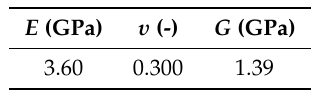
Table 1. Elastic properties of epoxy.